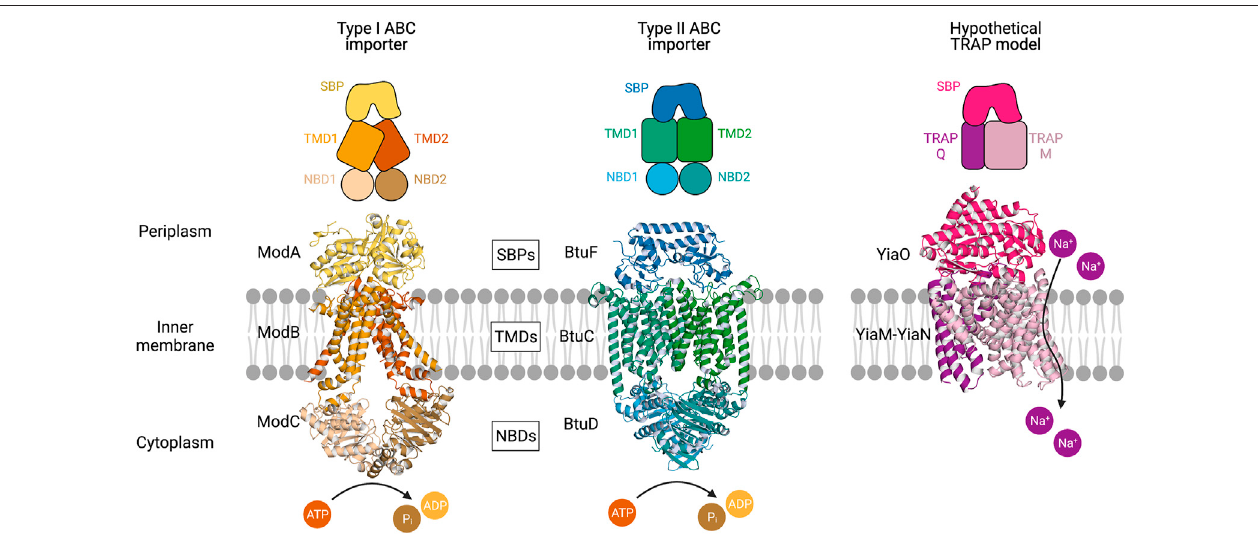
FIGURE 1 | Multicomponent transporters. Left, an experimentally determined structure of the type I ABC importer ModBC-A from A. fulgidus (PDB ID: 2ONK). Middle, an experimentally determined structure of the type II ABC importer BtuCD-F from E. coli (PDB ID: 2QI9) (Hollenstein et al., 2007; Hvorup et al., 2007). Right, a hypothetical model of the TRAP transporter YiaMN-O from E. coli that was generated by Ovchinnikov et al. (2014) using comparative modelling in RosettaCM . The substrate-binding proteins (SBPs) dock to the transmembrane domains (TMDs) at the periplasmic surface of the inner membrane. ABC transporter nucleotide- binding domains (NBDs) situated in the cytoplasm catalyse the hydrolysis of ATP. The TRAP transporter facilitates the movement of sodium ions across the